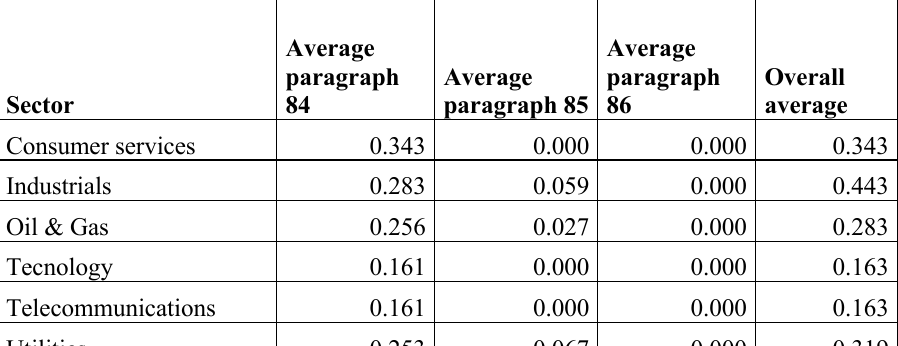
Table 4. “Weighted” disclosure index by macro sector: year 2016